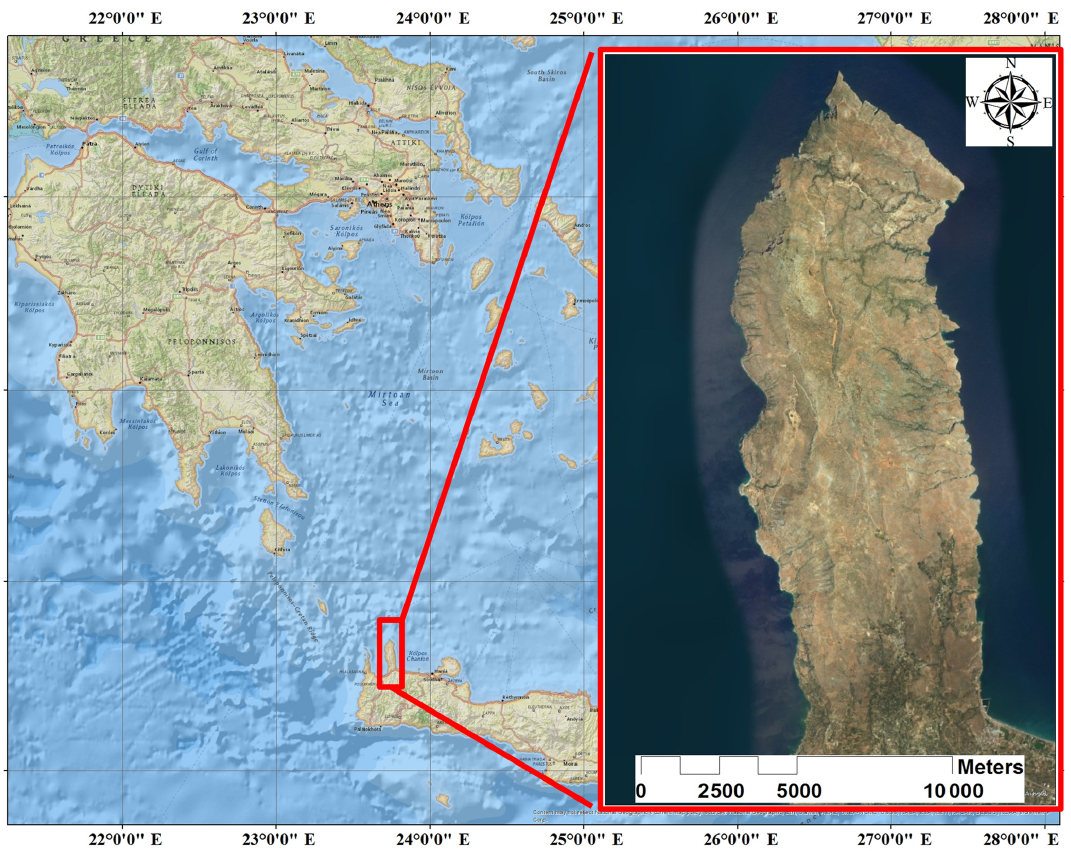
Figure 1. Location of the study